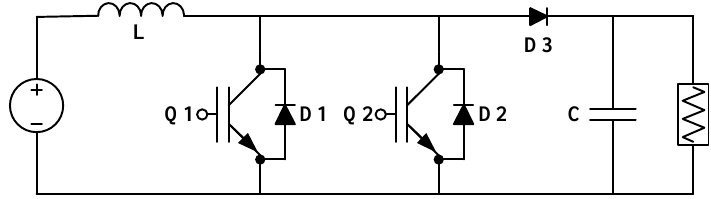
Figure 5. Circuit diagram of the multi-switch boost converter.